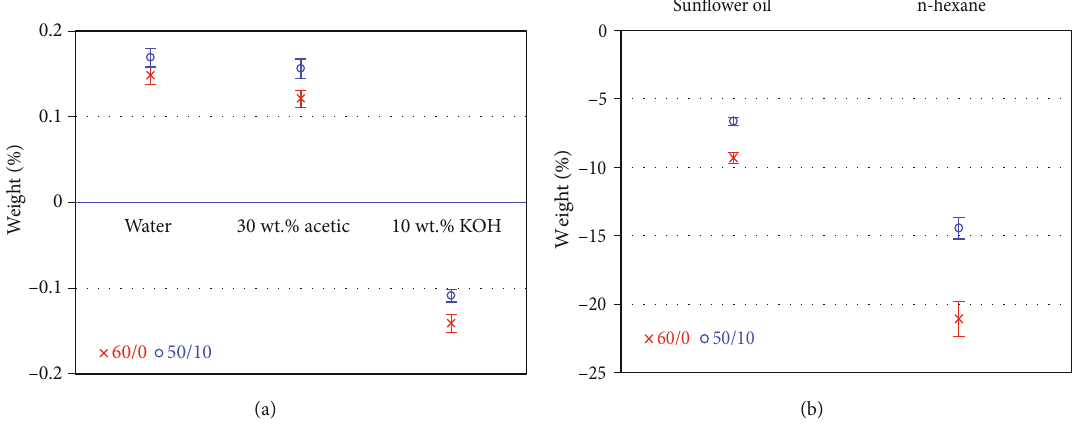
Figure 2: The e ff ect of EeRSO on the leaching property of PVC in media: (a) water, acid, and base; (b) sun fl ower oil and n-hexane.